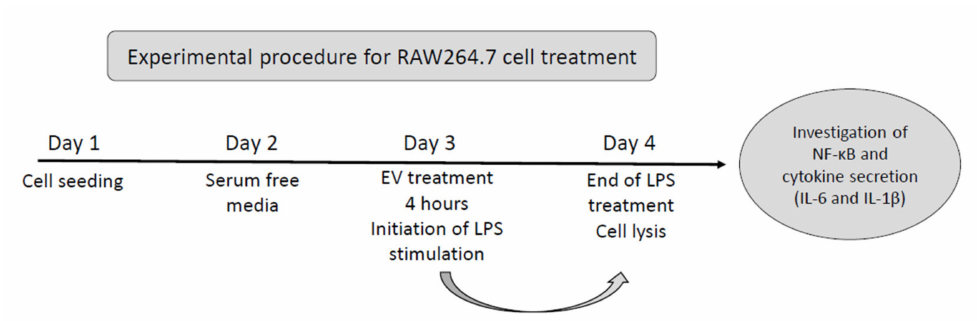
Figure 4. Experimental procedure for cell experiments. Initially, RAW264.7 cells were seeded in a 6-well plate and starved for 24 h to avoid effects of serum constituents before EV treatment for 4 h, followed by 18 h of LPS stimulation. Cell culture supernatant and cell lysate were harvested and used for I κ B α Western blots and cytokine